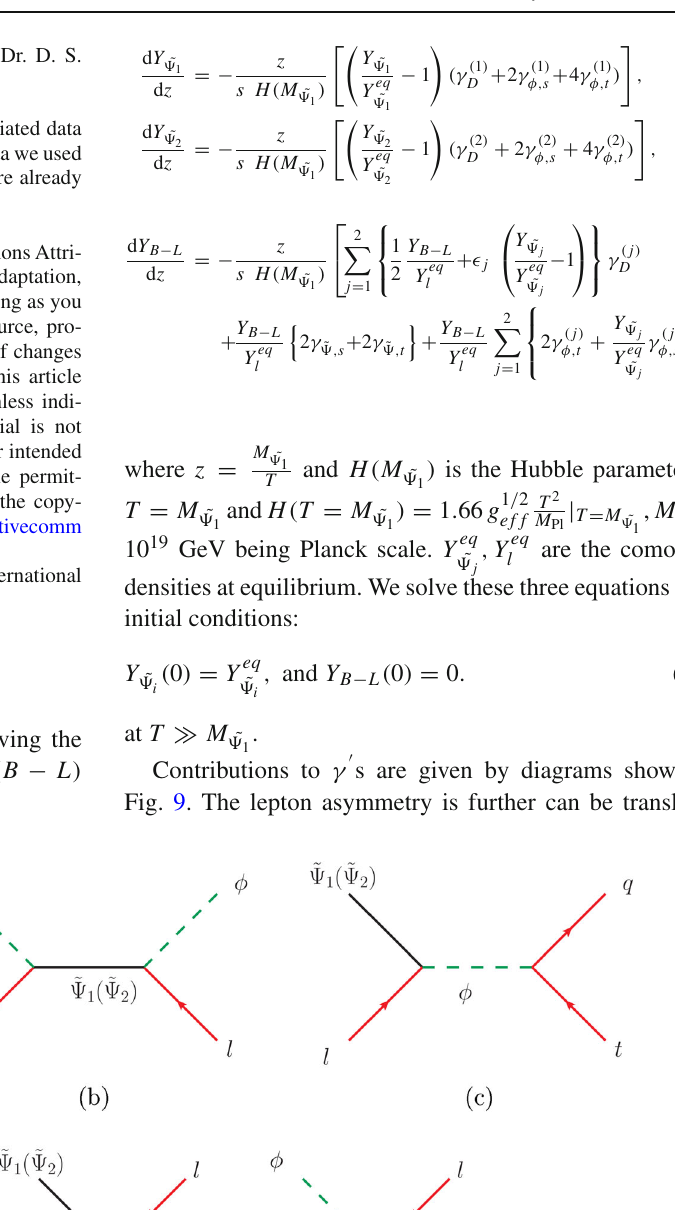
Fig. 9 Feynman diagram representing a decay of lightest heavy RH- neutrino ˜ (cid:9) 1 ( ˜ (cid:9) 2 ) (contributes to γ scattering via ˜ (cid:9) 1 ( ˜ (cid:9) 2 ) (contributes to γ ˜ (cid:9),